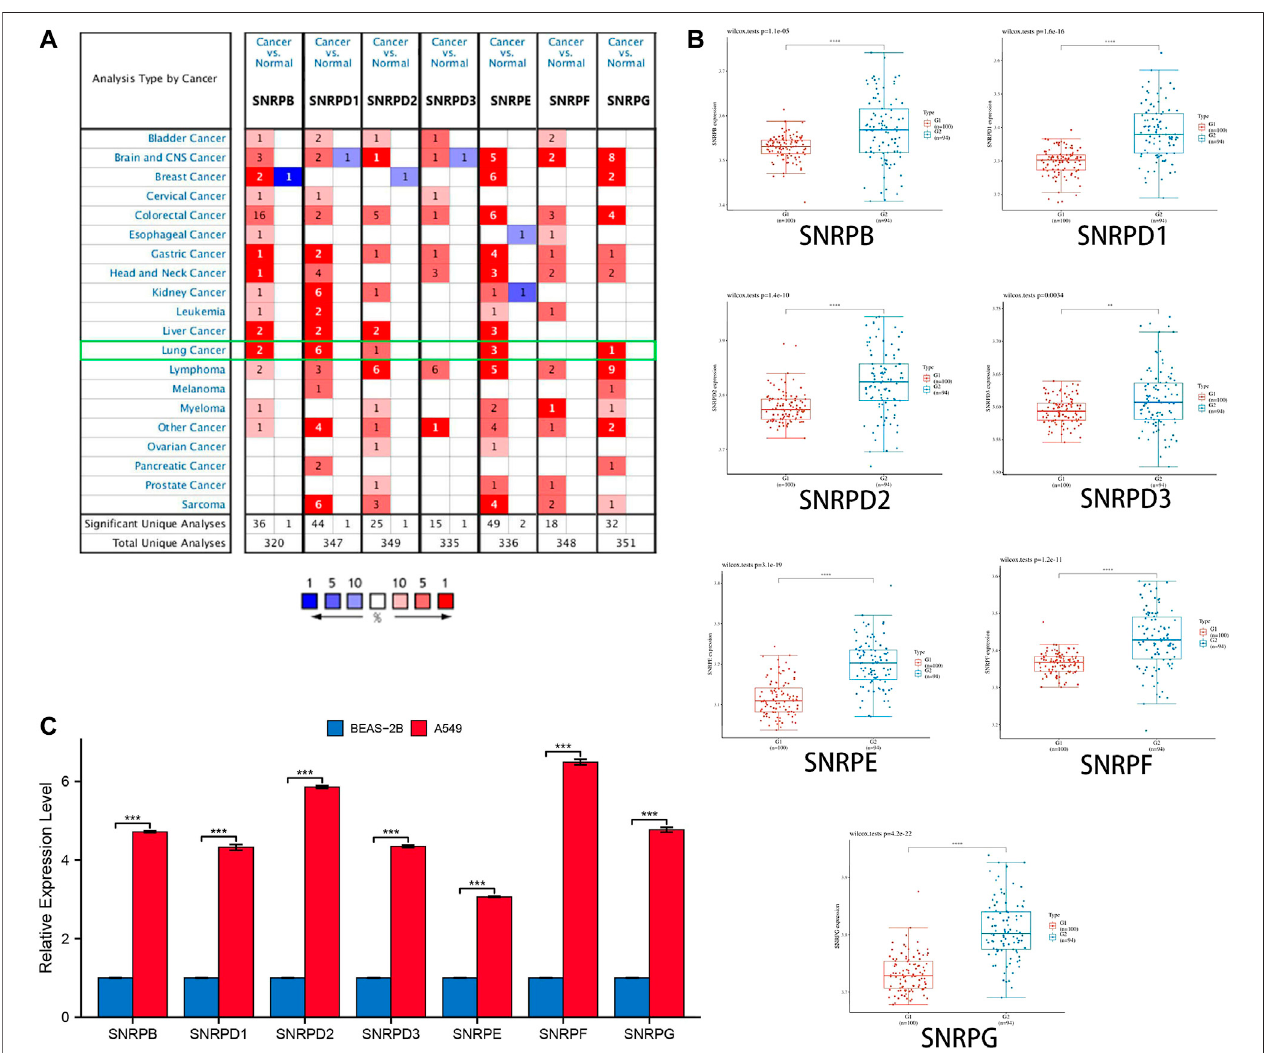
FIGURE 2 | The transcription levels of genes for Sm proteins in lung cancer tissues and lung cell lines. (A) The genes for Sm proteins in different human cancers (ONCOMINE). (B) Box plots of genes for Sm proteins expression between lung cancer and normal tissues in GSE40791. (C) Bar charts of mRNA level of genes for Sm proteins between BEAS-2B and A549 cell line. Students T-test was performed to assess the statistical signi fi cance. A p value of < 0.05 was regarded as statistically signi fi cant.